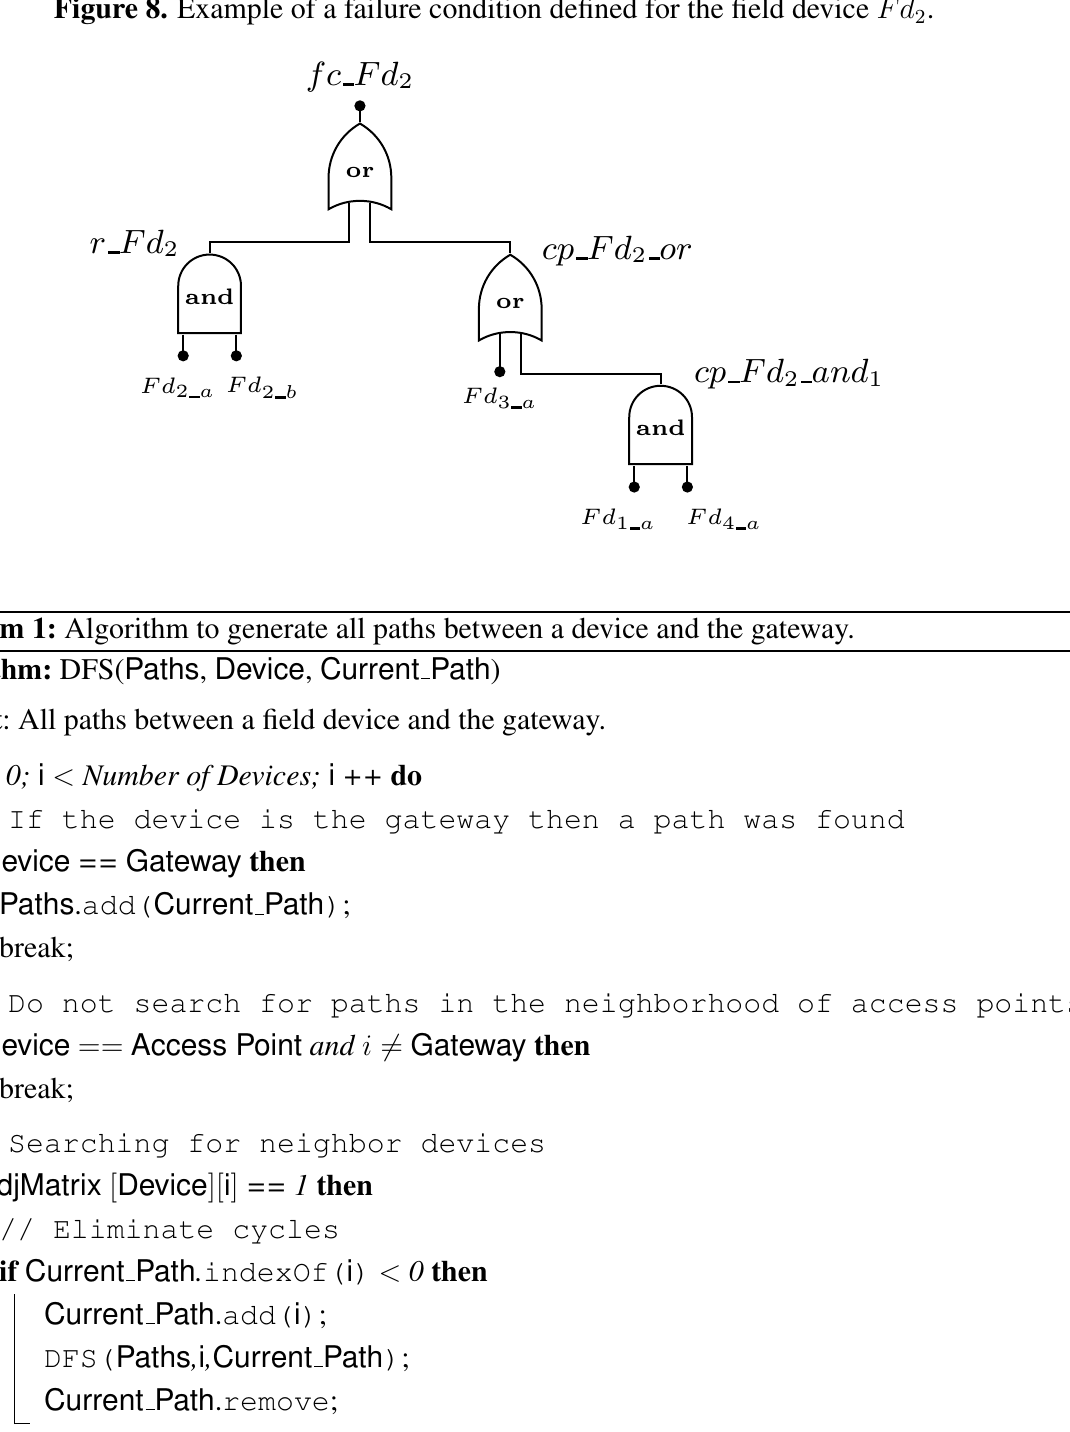
Figure 8. Example of a failure condition defined for the field device F d